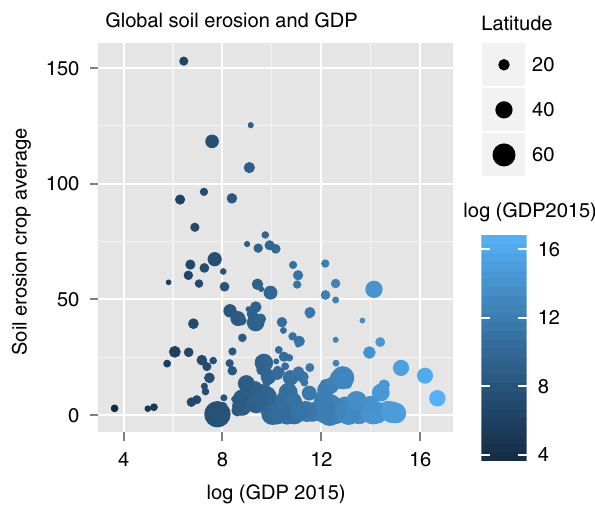
Fig. 7 Soil erosion in cropland areas on a country basis vs. the log of the respective countries GDP according to the World Bank. The size of the circle represents the latitude indicating the higher latitude, wealthier countries are the least impacted by soil erosion, either through